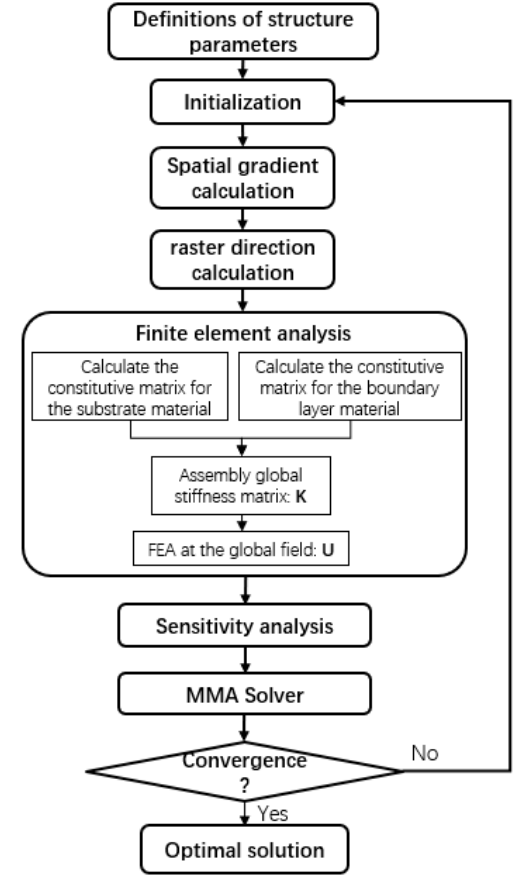
Figure 4. The flow chart of the proposed method.